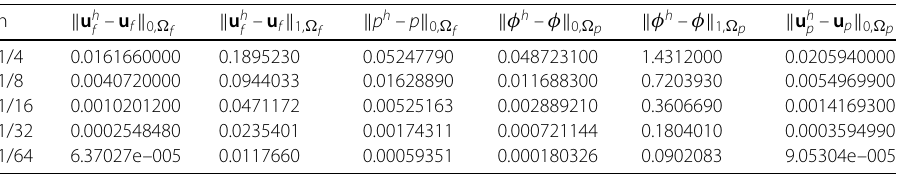
Table 2 Approximate error of the stabilized finite scheme for test 2 with K = 0.1 I